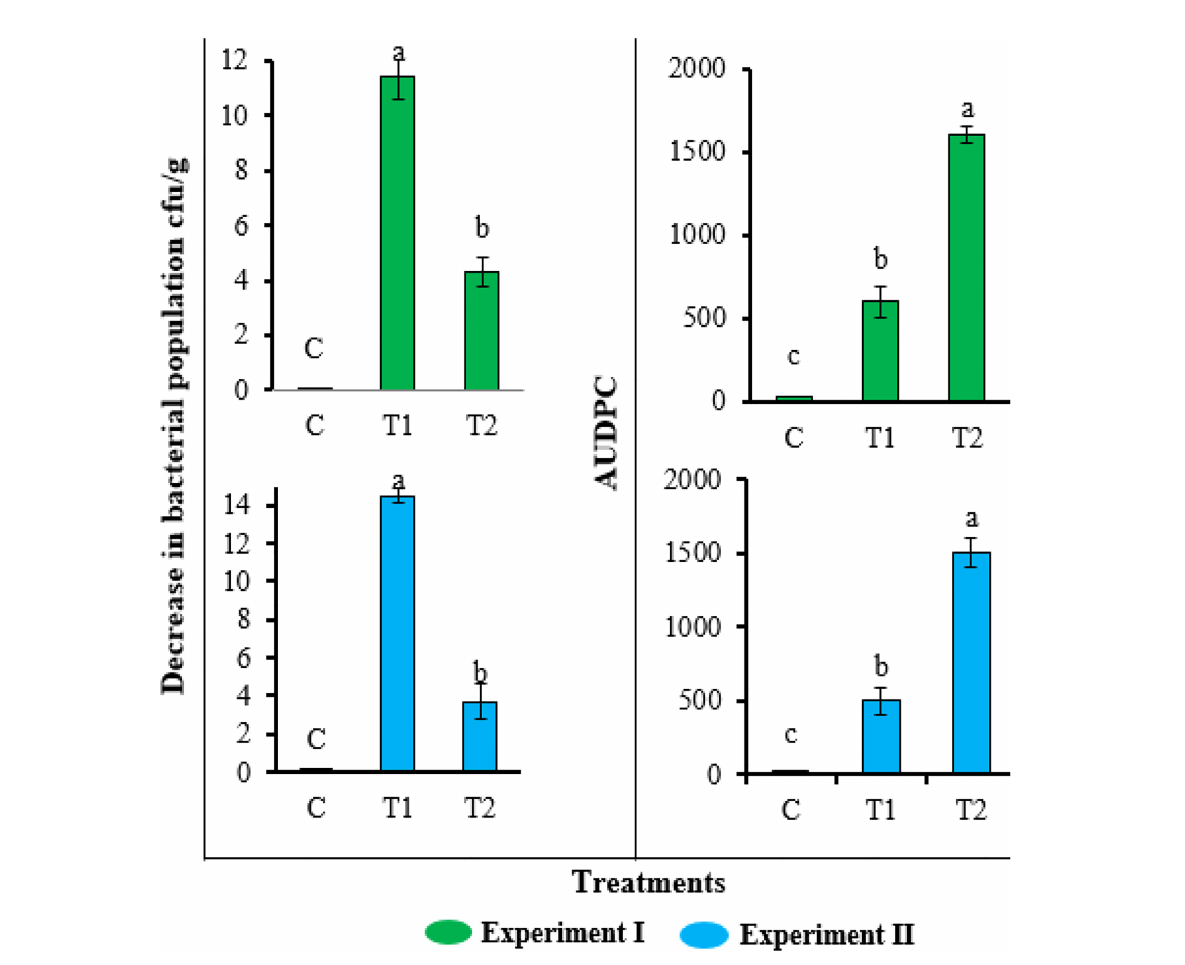
FIGURE 6 Effect of different concentrations of furoic acid (FA) on Ralstonia solanacearum population in soil and disease severity area under the disease progress curve value in fi eld experiment. C, control plants; T1, plants inoculated with R. solanacearum and treated with FA (Rs + FA); T2, plants inoculated with R. solanacearum (Rs). Bars represent the standard error. Lower case lettering shows the signi fi cant difference among the treatments.